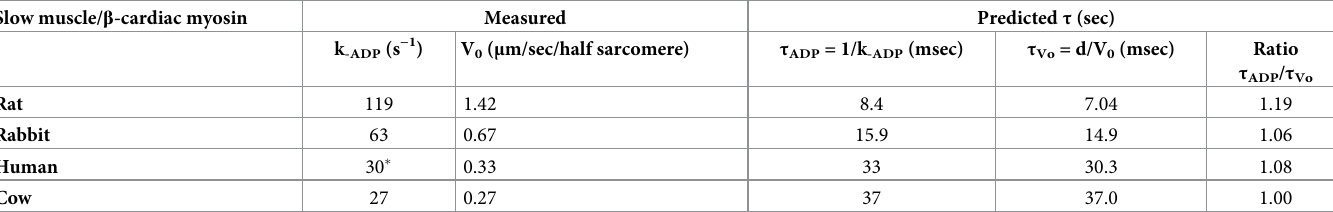
Table 2. The relationship between the predicted and measured parameters for 4 slow/beta cardiac myosin isoforms. Slow muscle/ β -cardiac